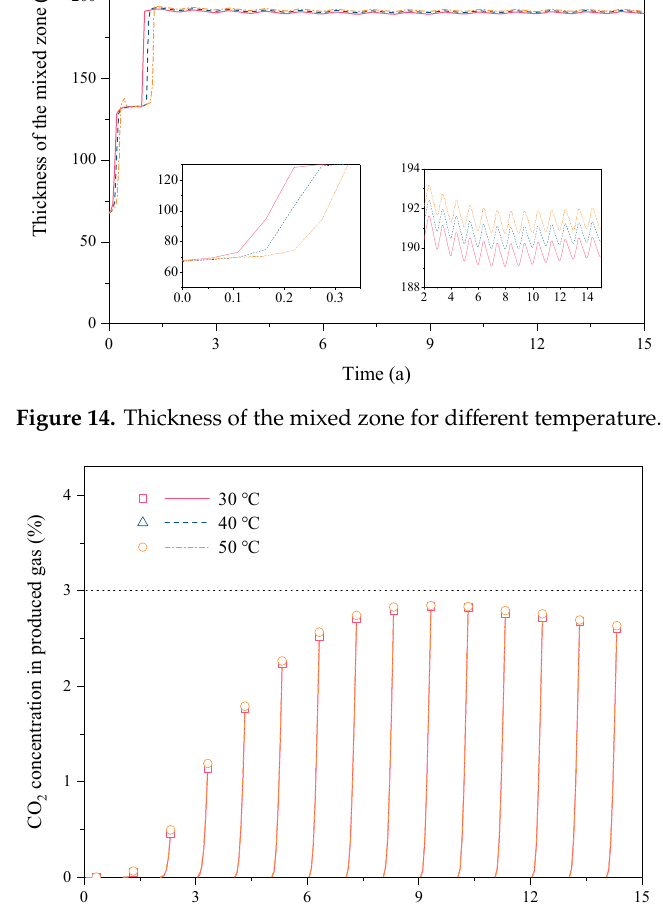
Figure 15. CO 2 concentration in the produced gas for di ff erent